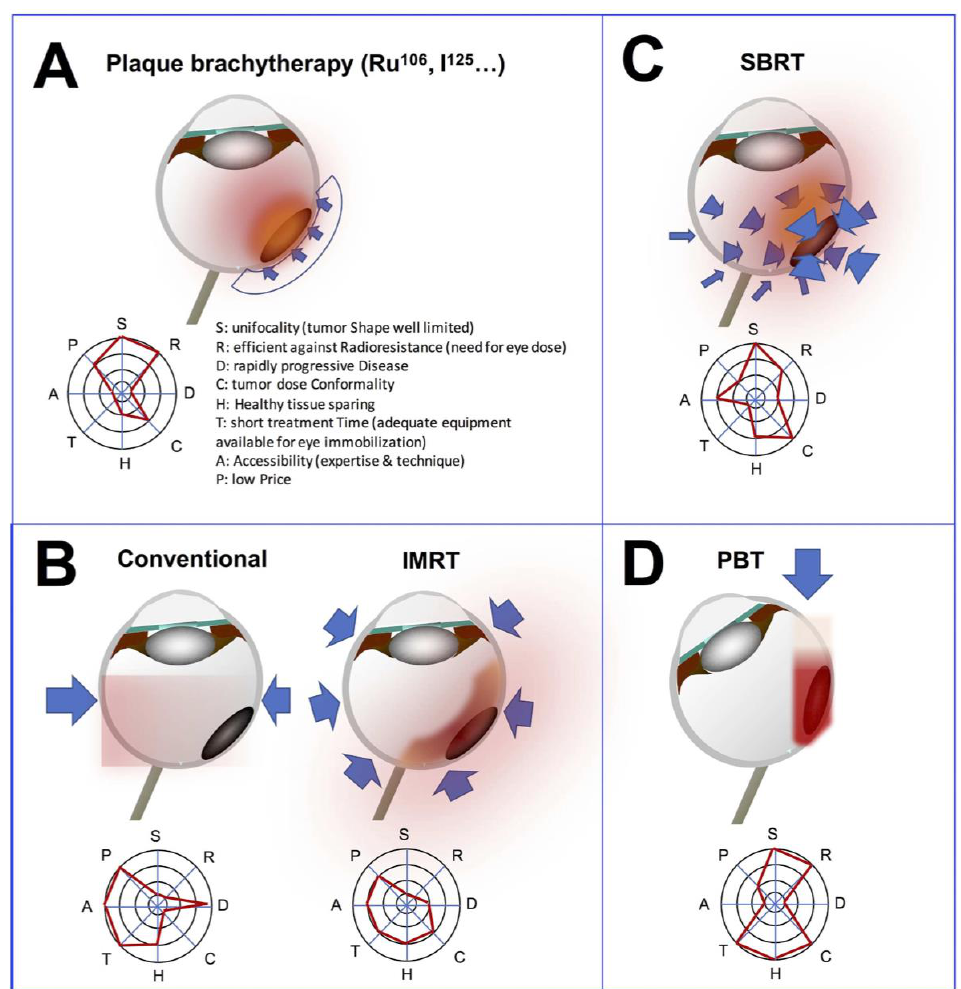
Figure 1. Radiotherapy techniques of and corresponding radar charts. ( A ) Brachytherapy is a con- formal technique that does not deliver radiation dose outside the eye. The principle is to apply a radioactive isotope to the sclera that will deliver radiation over a short distance to the tissue. The plaque delivers a heterogeneous dose from the sclera to the apex of the tumor. ( B ) Conventional 3D radiotherapy delivers a uniform dose to the eye using 1 to 3 fields. Intensity-modulated radiother- apy (IMRT) uses 5 to 9 fields and a multileaf collimator, allowing complex concave radiation dose distribution. ( C ) Stereotactic beam radiotherapy (SBRT) delivers radiotherapy from many different positions around the organ so that the beams meet at the tumor. The tumor receives a high dose of radiation and the healthy tissues around it only a low dose. ( D ) Proton beam therapy (PBT) allows a very focused and high-dose volume of energy deposition due to the physical properties of protons. The energy is delivered with a sharp Bragg peak allowing preservation of surrounding tissues. Adapted from Mathis et al., 2019 [14].